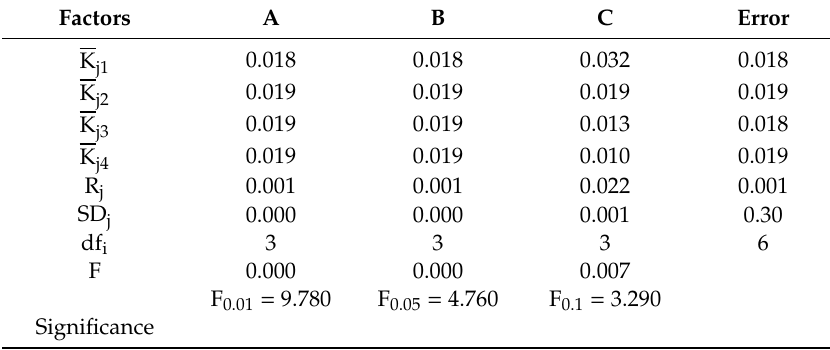
Table 4. Range analysis for degradation rate of epoxy